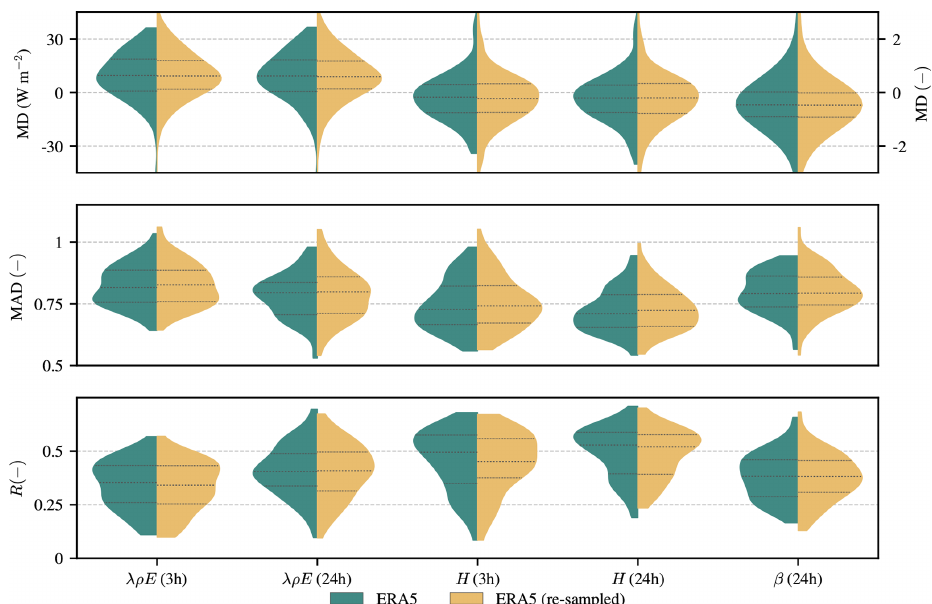
Figure A2. Violin plots of temporal validation statistics of the surface latent heat flux ( λρE ), surface sensible heat flux ( H ), and Bowen ratio ( β ) from ERA5 (green) and ERA5 linearly resampled to the spatial grid of ERA-I (yellow). Statistics are calculated against in situ eddy- covariance measurements at both 3-hourly and daily temporal resolutions. Violin plots represent the distribution of the individual validation statistics with indication of the median and interquartile range and are calculated using a kernel density estimation approach. Statistics include the MD (raw in situ time series from 143 sites as reference), MAD (anomaly in situ time series from 77 sites as reference), and R (anomaly in situ time series from 77 sites as reference). The distribution of the MD of β is plotted on the right y